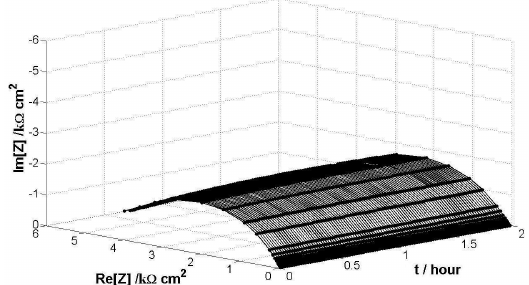
Figure 6. DEIS result of Al-2007 alloy, with 1500 ppm mad honey in 3.5% NaCl solution.